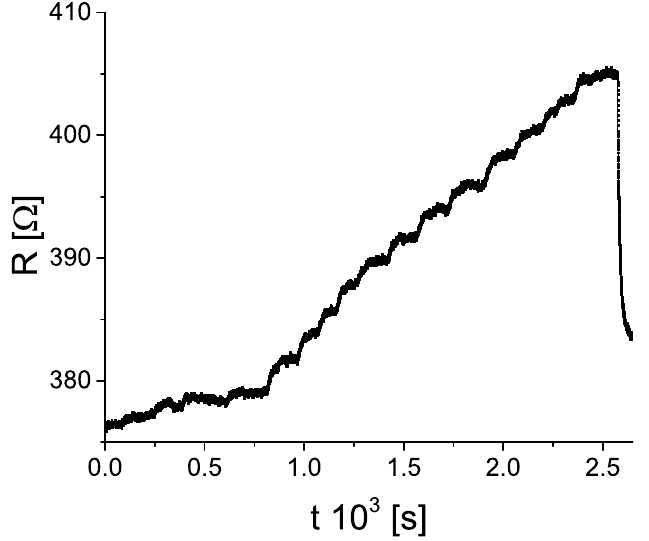
Figure 4. Resistance of the oxidized sample upon exposure to increasing concentration of methanol vapour. For details see Section